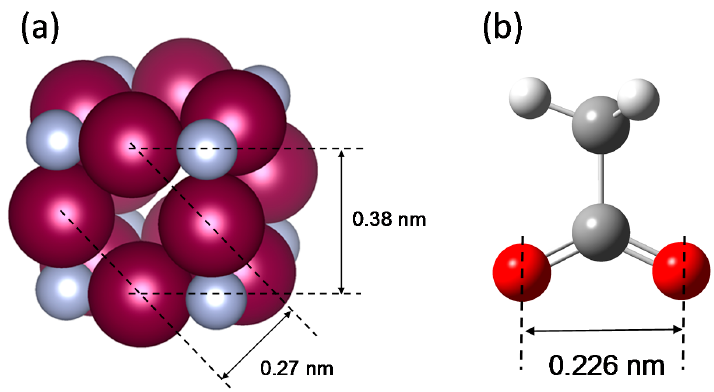
Figure 6. Images of ( a ) the crystal structure of copper nitride and ( b ) the molecular structure of the acetate ion.